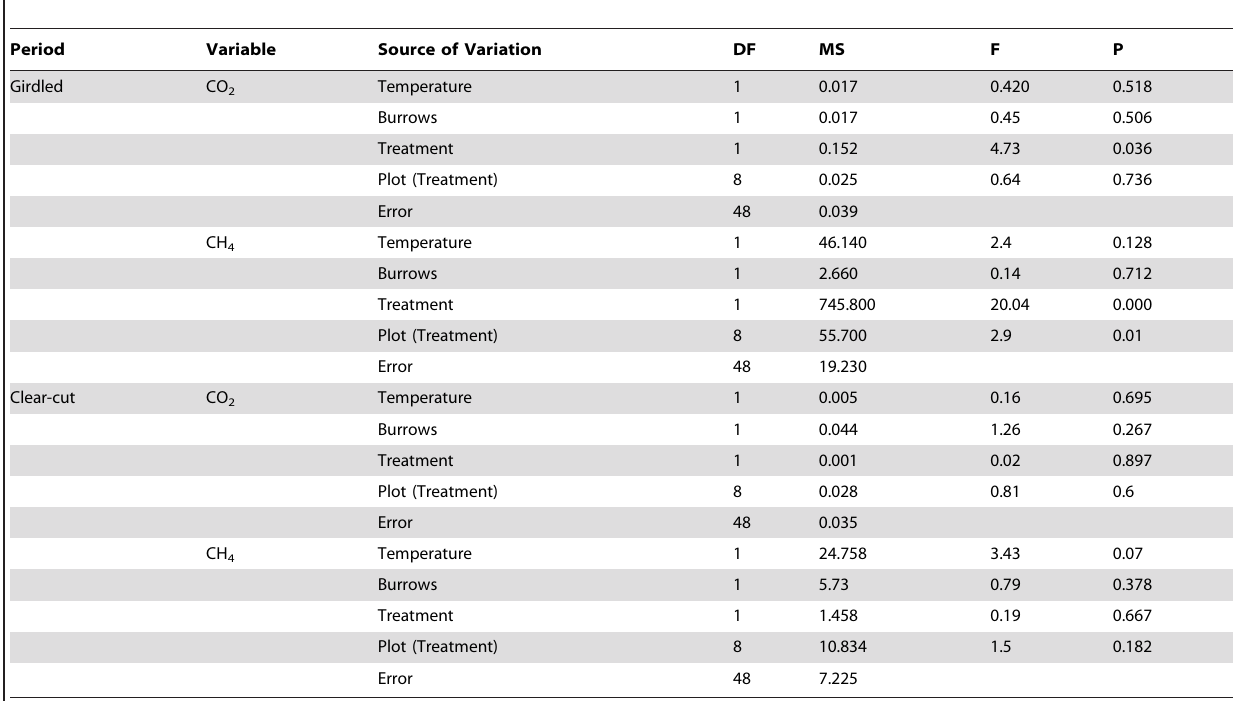
Table 1. Nested design ANOVA for carbon fluxes in R. mucronata secondary forest, with mean data for each of six chambers per plot nested within treatment; the data for CO 2 were